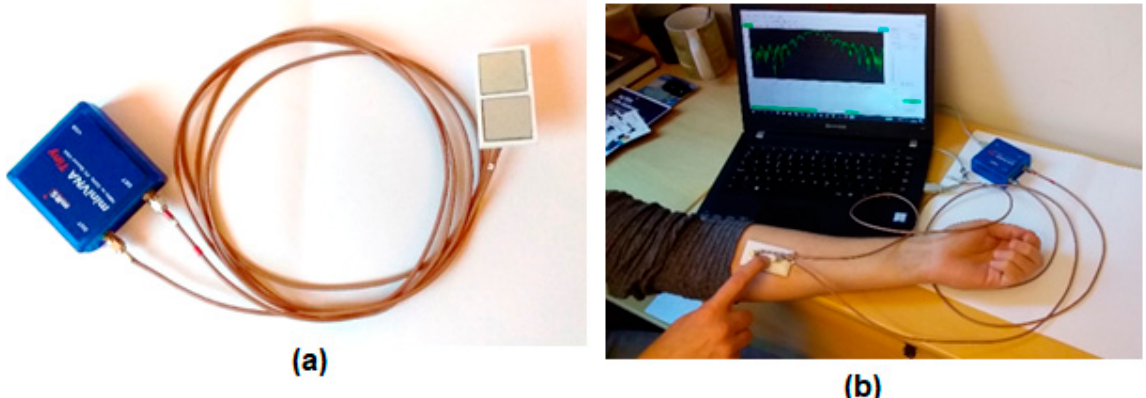
Figure 4. Photographs of the miniVNA and the split-ring resonator ( a ) and measuring the muscle mass on the ventral side of the lower arm ( b ).